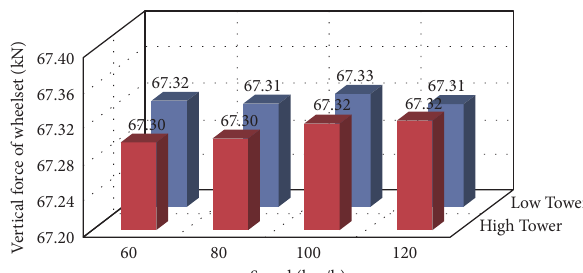
Figure 12: Comparison of vertical force of wheelset.